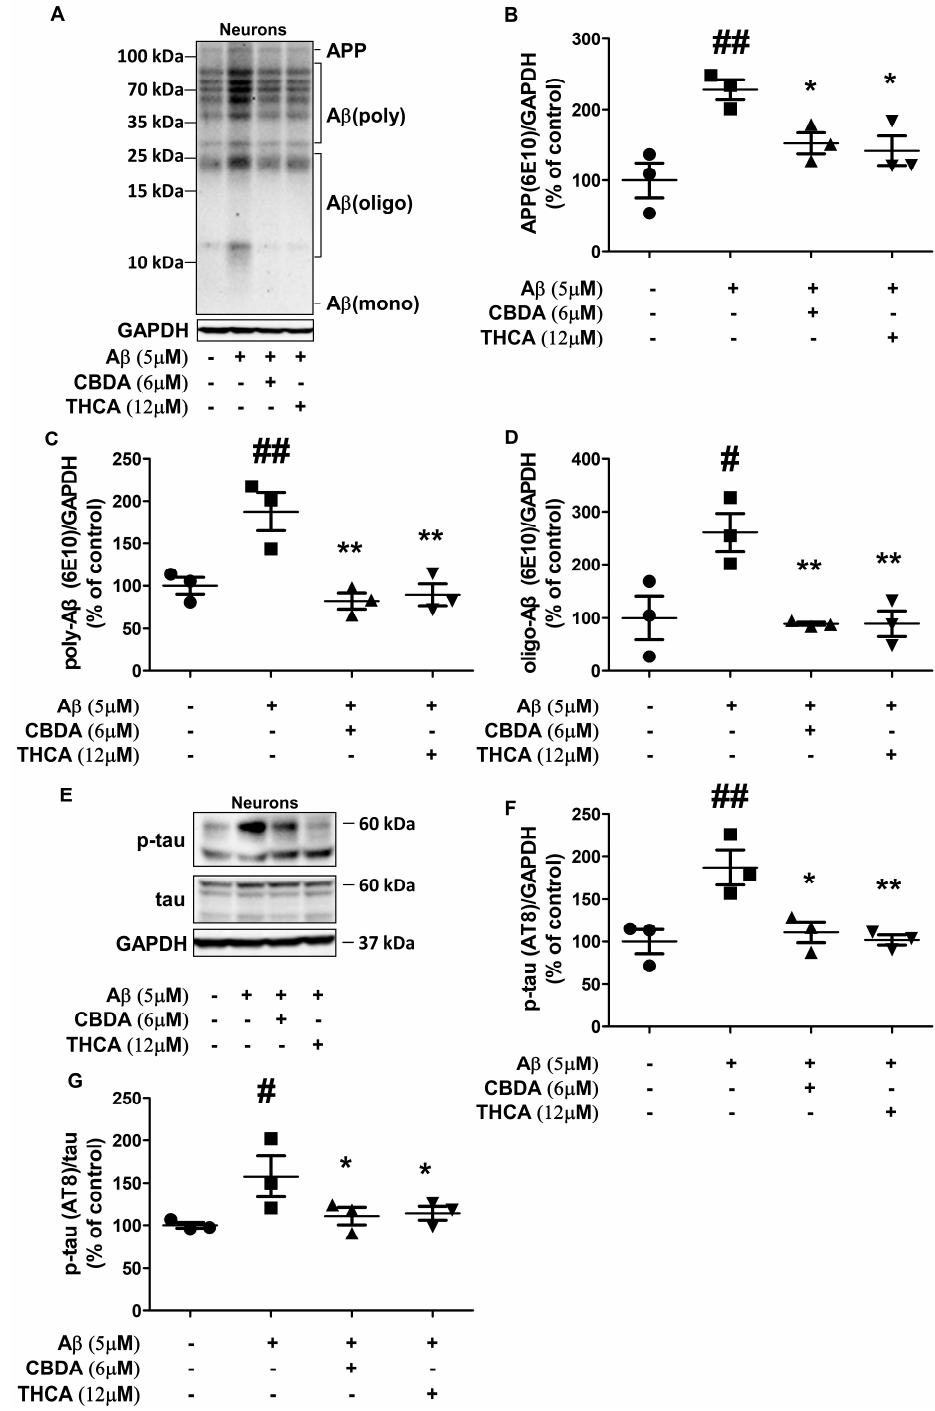
Figure 2. Effects of CBDA and THCA on A β and p-tau levels in primary neurons. ( A ) Representative Western blots of APP/A β proteins. ( B–D ) Western blot densitometry results for ( B ) APP, ( C ) polymeric A β , and ( D ) oligomeric A β . ( E ) Representative Western blots of tau and p-tau protein. ( F , G ) Western blot densitometry results for ( F ) p-tau (AT8), ( G ) p-tau (AT8)/tau. (mean ± SEM, # p < 0.05 and ## p < 0.005 vs. PBS-treated, * p < 0.05 and ** p < 0.005 vs. A β 1-42 -treated, one-way ANOVA followed by Fisher’s LSD; test; n = 3 per group).